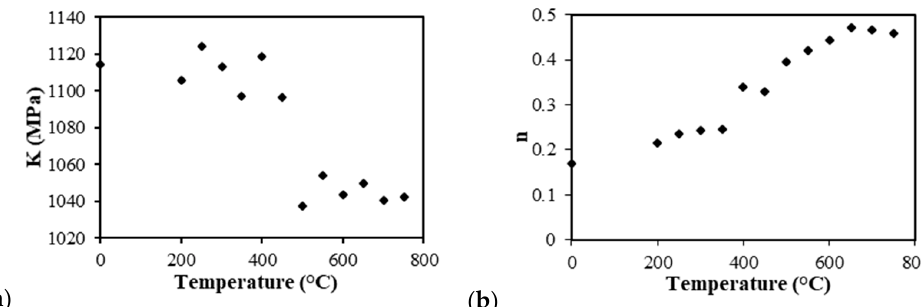
Figure 10. The strength coefficient ( a ) and strain ‐ hardening exponent ( b ) of the samples by annealing temperature.